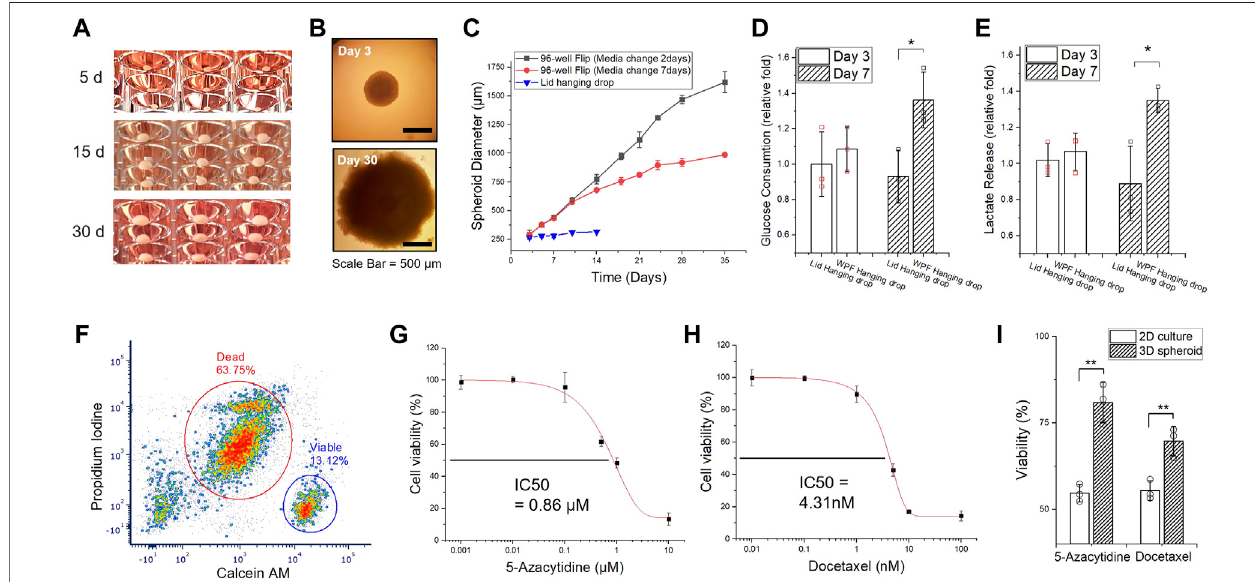
FIGURE 3| Long-term culture of 3D HCT116 spheroids. (A) Images of 3D spheroids cultivated for an extended time (Day 5, Day 15, and Day 30). (B) Microscopic images of 3D spheroids (on Day 3 and Day 30). (C) The size measurement of HCT116 spheroid for 35 days. The medium was manually replaced after Day 7 (black line: Every 2 days, red line: Every 7 days) through a well-welltransfer technique ( Supplementary Figure S3 ). (D) Glucose uptake and (E) lactate release of 3D spheroids on Day 3 and Day 7, generated in different conditions, fl ipped well-plate method and conventional lid hanging drop method. (F) Flow-cytometric measurement of HTC116tumorspheroidswitha1-monthculture.ThespheroidsweredissociatedcompletelyandstainedwithCalcein-AMandpropidiumiodide(PI)forlive/deadassay. (G) 2D cell death index determination of 5-azacytidine and (H) Docetaxel. The half the maximal inhibitory concentration (IC50) values of the drugs were determined from the results of the 2D responses of HCT116 cells. (I) Discrepancy of cell viability assay between 2D and 3D cultures with IC 50 of 5-azacytidine and docetaxel. All data represent mean ± SD ( n = 3, biological replicates per condition); * p < 0.05; ** p < 0.01; Signi fi cance by Student ’ s t